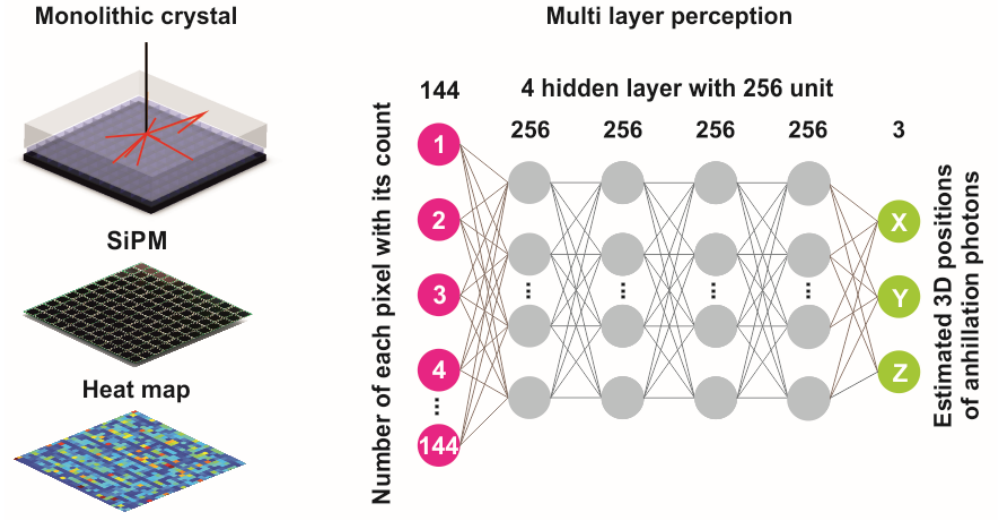
Figure 1. The network architecture and schematic diagram of the model used in this work.